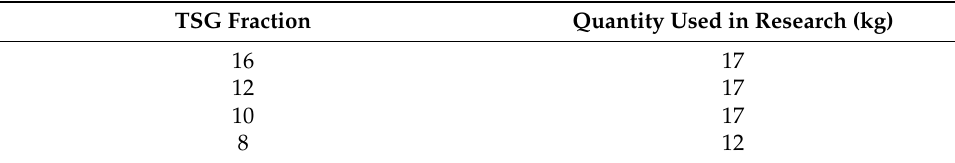
Table 2. Quantities and dimensions of used technical glass beads.